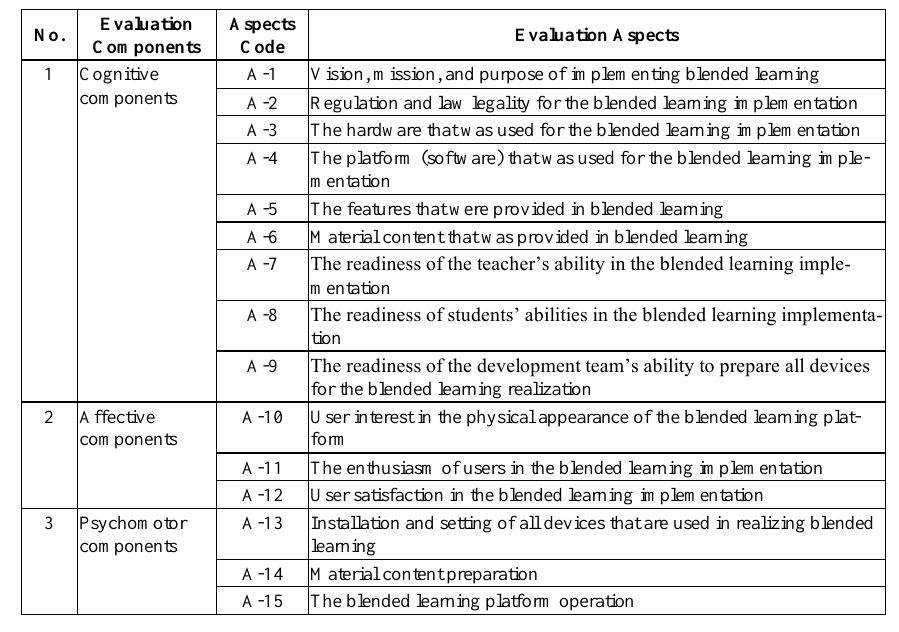
Matrix Evaluation